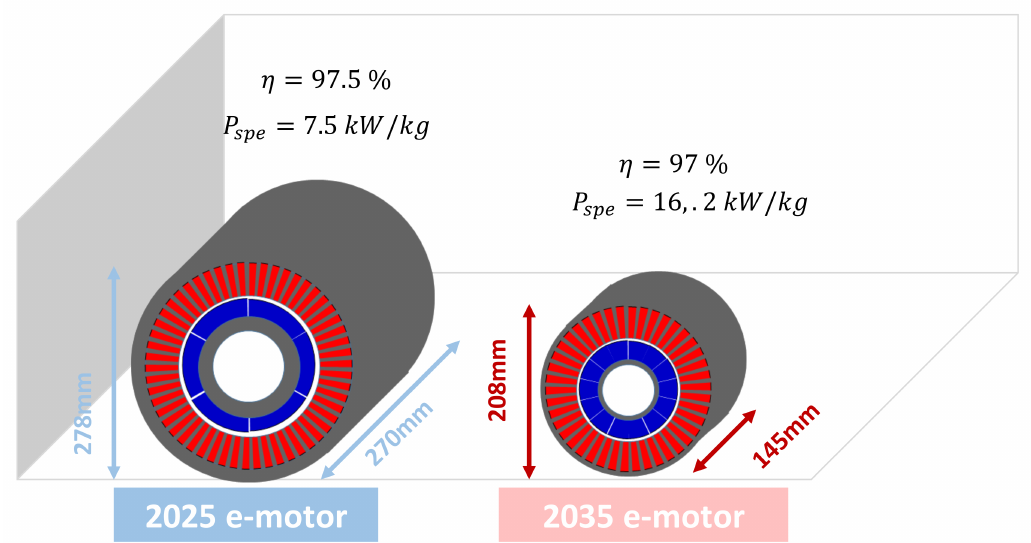
Figure 20. Geometrical comparison of the optimal actuators ( left : base cooling system, right : external and internal cooling system).